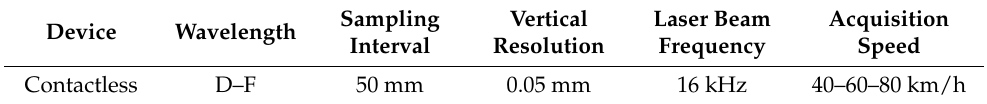
Table 4. Characteristics of the laser profiler and